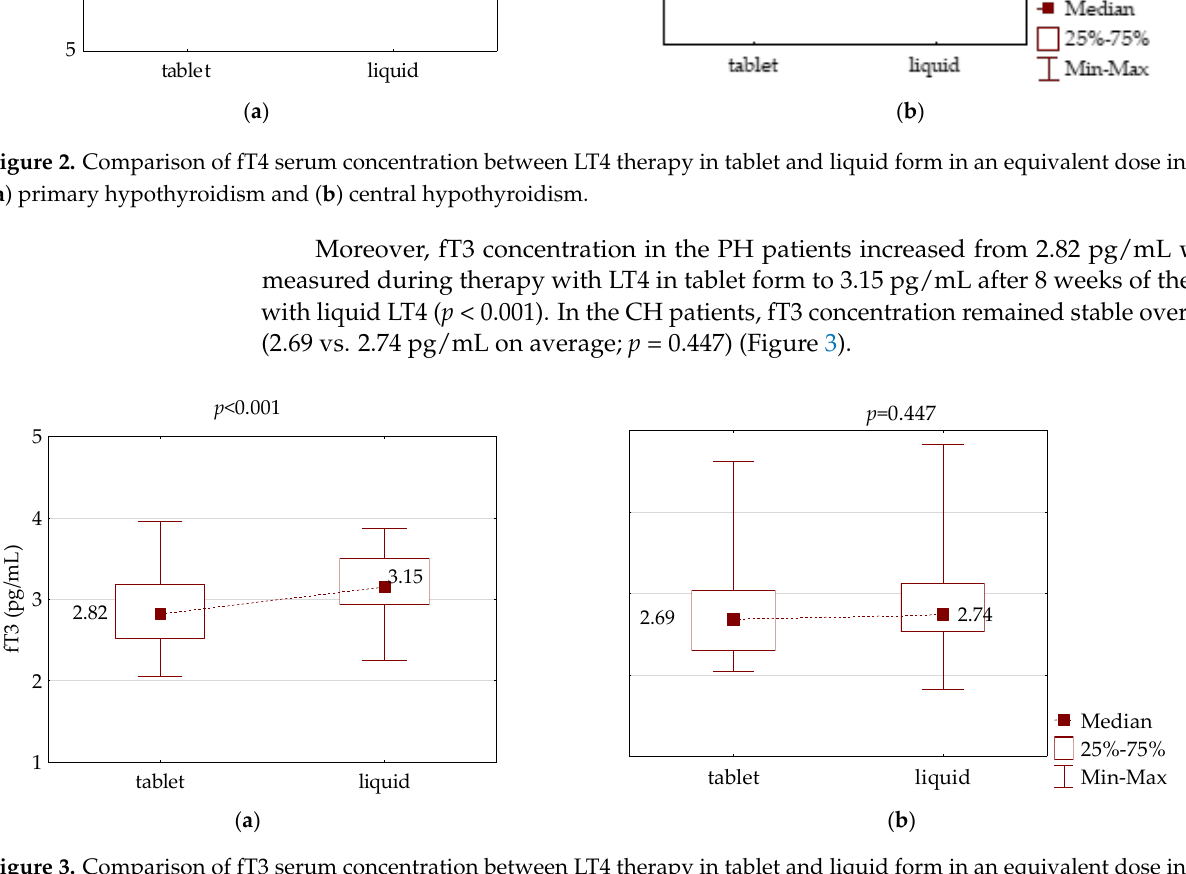
Figure 3. Comparison of fT3 serum concentration between LT4 therapy in tablet and liquid form in an equivalent dose in: ( a ) primary and ( b ) central hypothyroidism.